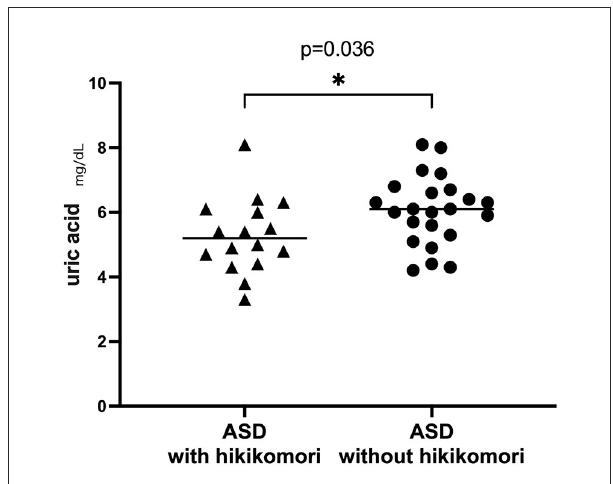
FIGURE1 Uric acid in hikikomori and non-hikikomori cases.